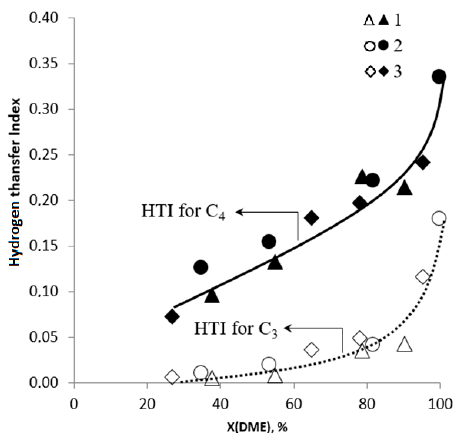
Figure 10. Hydrogen transfer index as a function of DME conversion (X (DME), %). 1—HZSM-5 / Al 2 O 3 ; 2—Zr-HZSM-5 / Al 2 O 3 ; 3—Mg-HZSM-5 / Al 2 O 3 . HTI for C 3 hydrocarbons—dashed line; HTI for C 4 hydrocarbons—solid line.